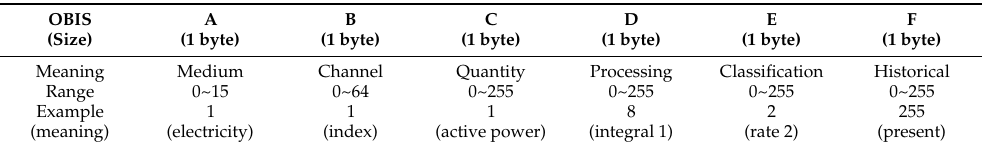
Table 3. OBIS code structure and usage example.